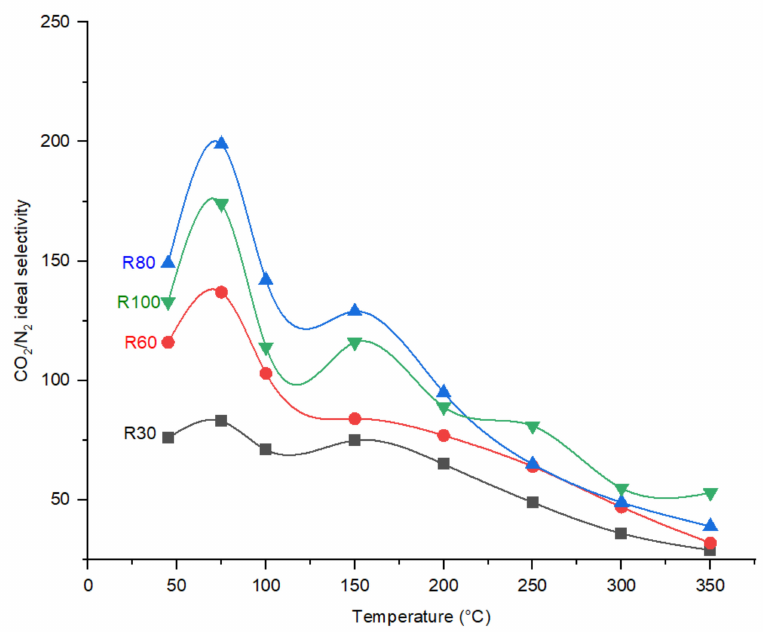
Figure 10. Effect of operational temperature CO 2 /N 2 ideal perm-selectivity the CMSMs (Carbon Molecular Sieve Membranes) with varying the DP (Degree of Polymerization) in the polymer at 6 bar operational